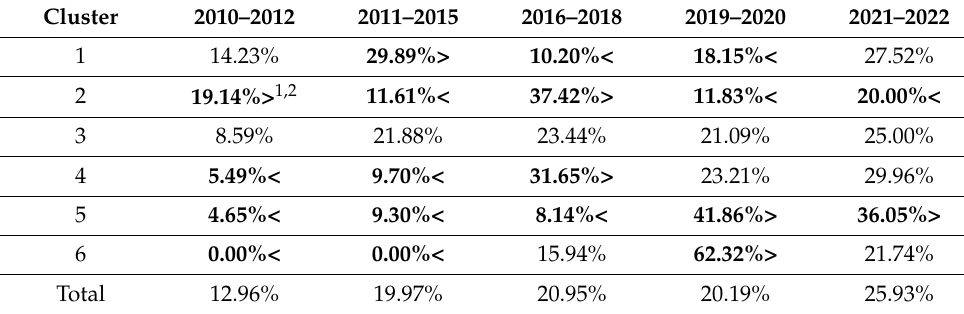
Table 7. Distribution clusters by year of reporting of all the sequences.